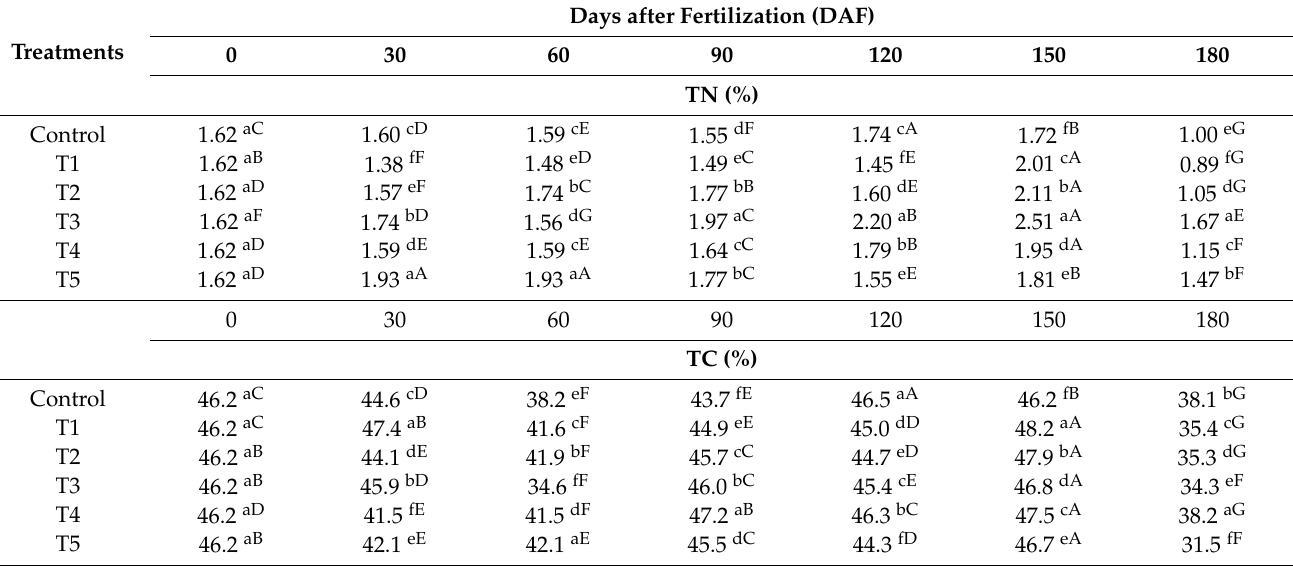
Table 4. Total nitrogen (TN) and total carbon (TC) of substrate samples of cocoa plants under different fertilization rate of 0–6 months.